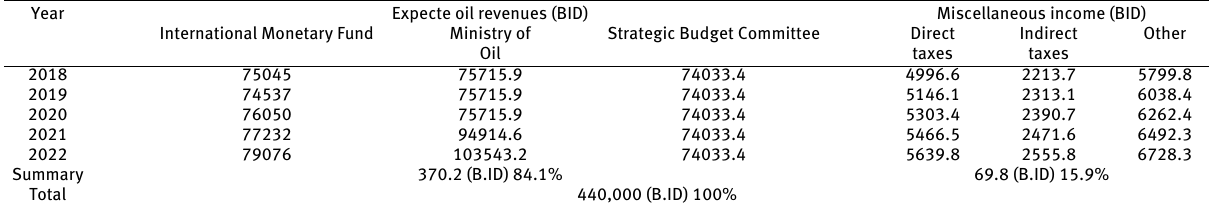
Table 4: Overall Expected Income Year